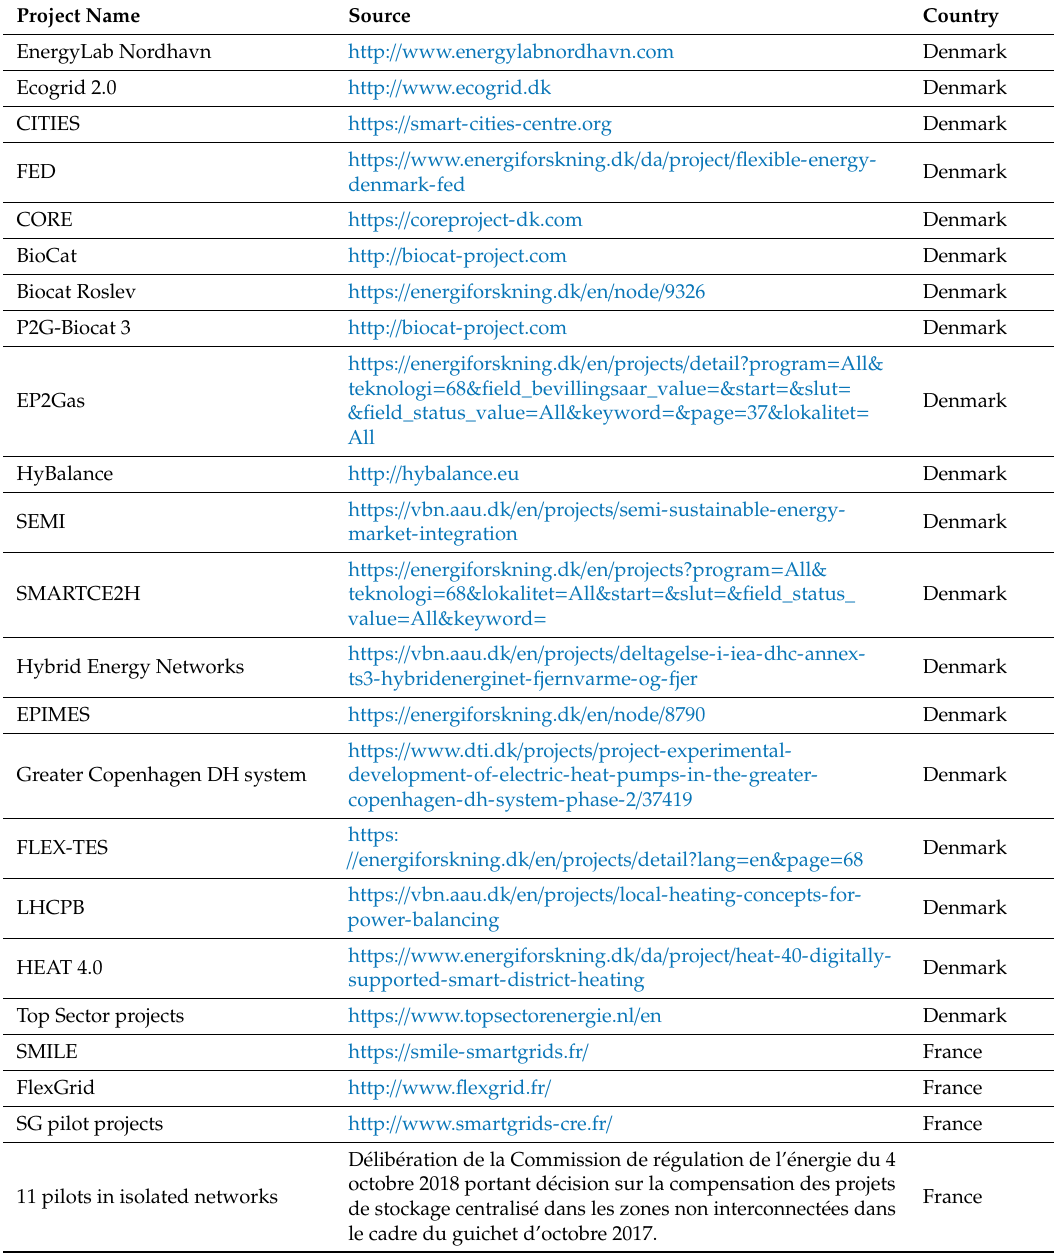
Table A1. List of projects and